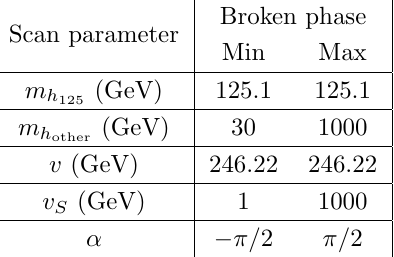
Table 1 . Parameter ranges used for the input parameters of the broken phase of the RxSM : the mass of one of the two visible scalars was (cid:12)xed to the measured Higgs mass value m h the other mass m h is scanned over. other